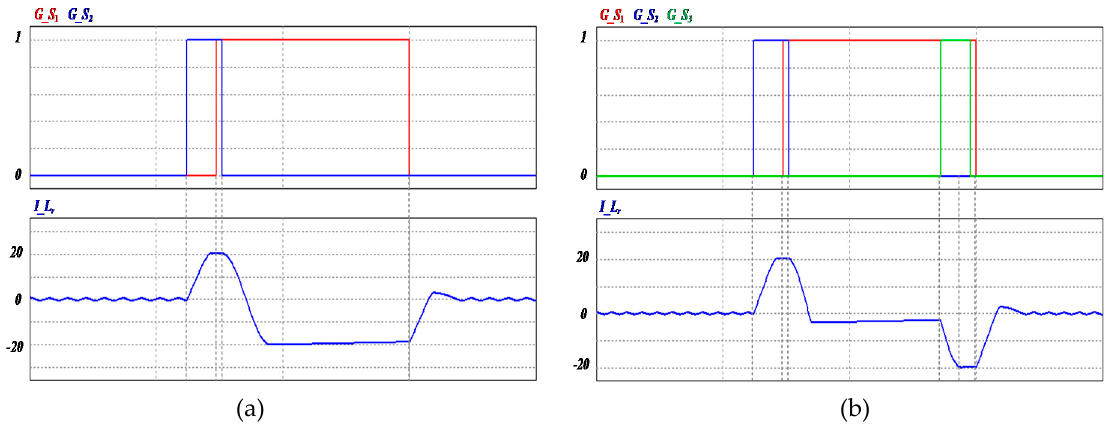
Figure 15. Waveforms of PWM signal and resonant inductor current. ( a ) Conventional converter and ( b ) proposed converter.